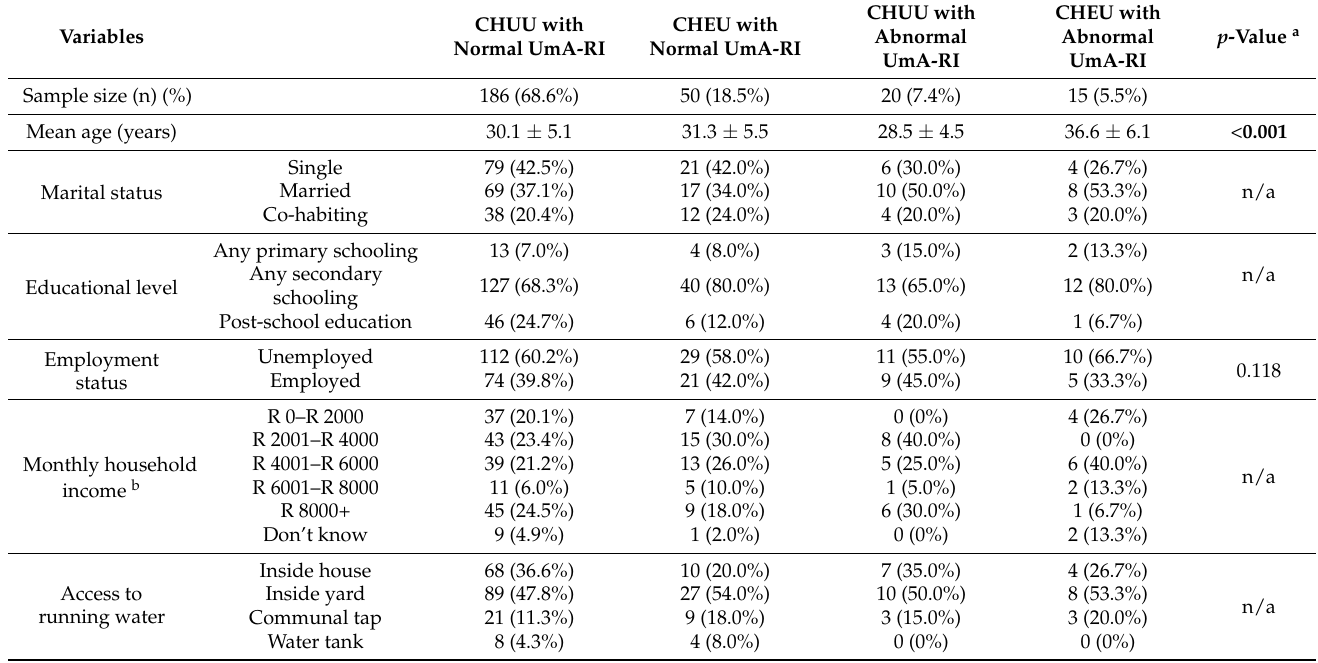
Table 1. The maternal socio-demographic and medical